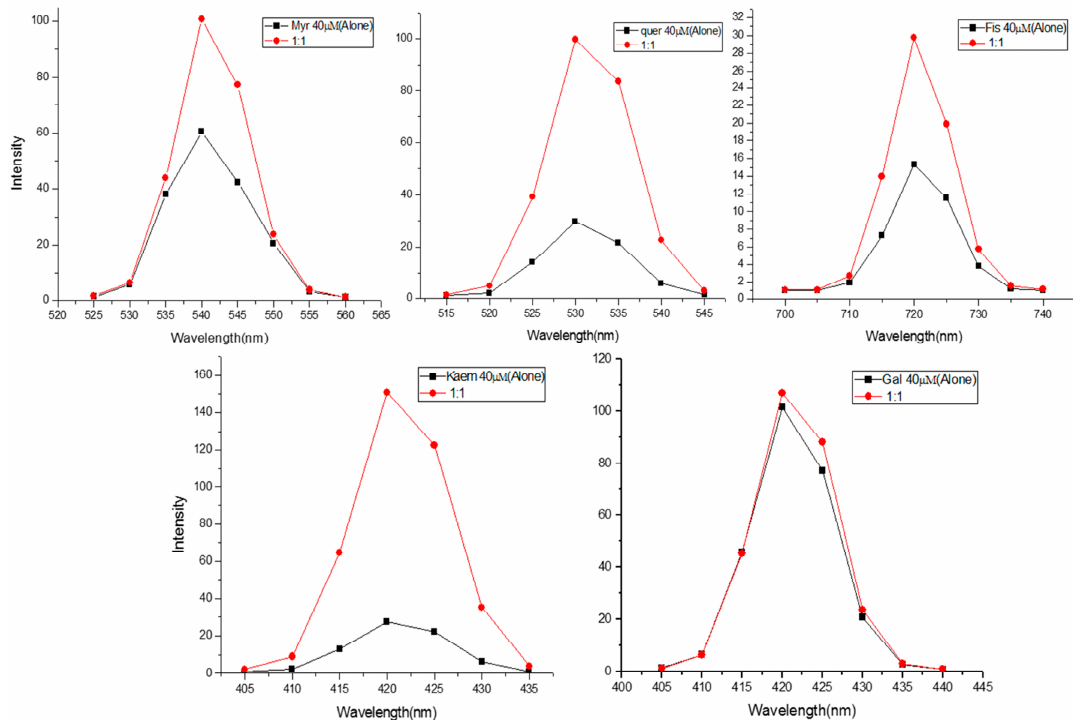
Figure 2. Effect of increasing native DNA base pair molar ratio on the fluorescence emission spectra of Flavonoids. Flavonoids were excited at different wavelengths ( MN = 380 nm, FN = 365 nm, QN = 370 nm, KL = 365 nm, GN = 365 nm) in the presence of increasing native DNA base pair molar (1:1) and the emission spectra were